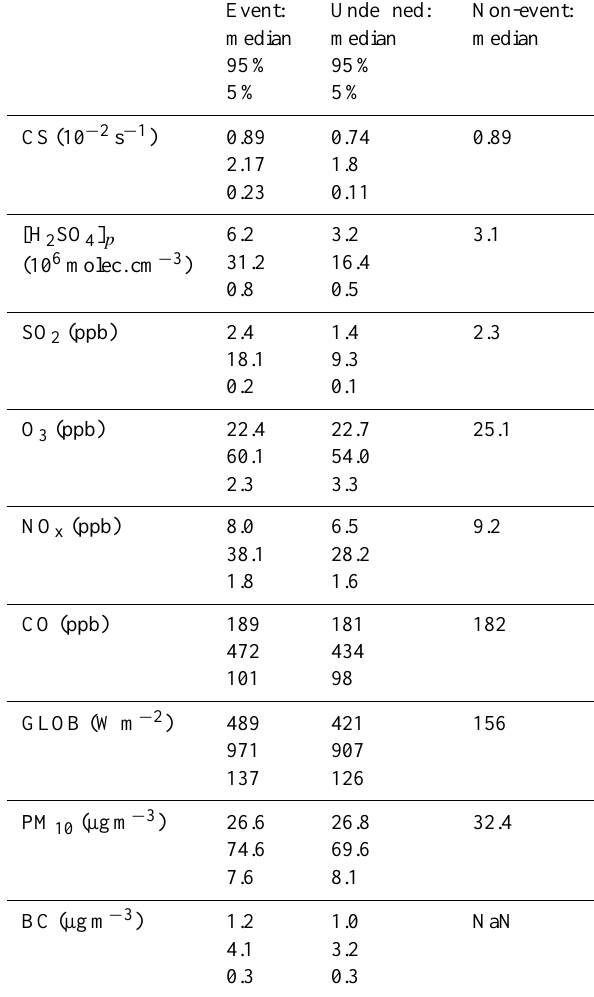
Table 1. Median, 95th and 5th percentiles of global radiation, trace gas and estimated sulphuric acid concentrations, particle mass (in prevailing conditions) and black carbon mass concentrations during 08:00–14:00 local time on particle formation and undefined